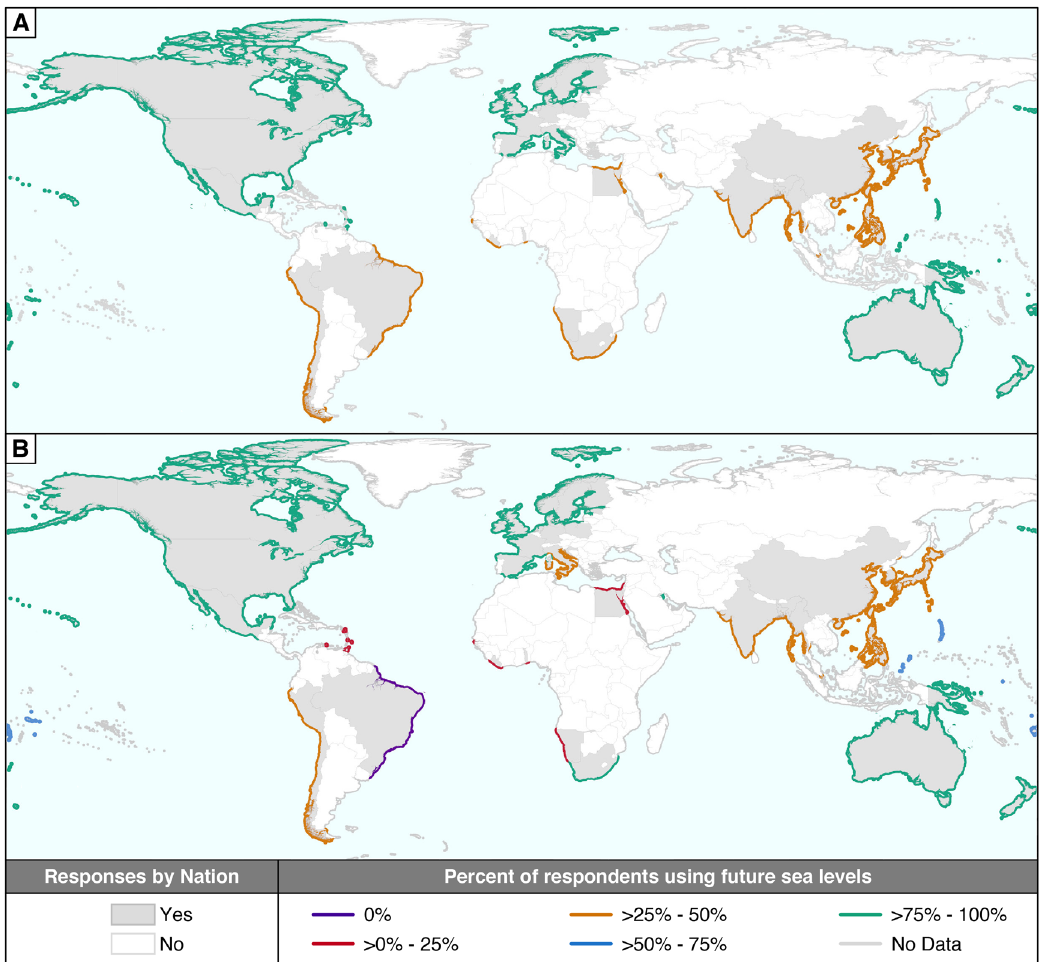
Fig. 1 Study scope and use of sea-level rise projections in planning. Percent of respondents by continent ( A ) and coastal region ( B ) who are using sea-level rise in coastal planning processes and the countries (in gray) that provided responses. See Supplementary Table 2 for a list and details of coastal